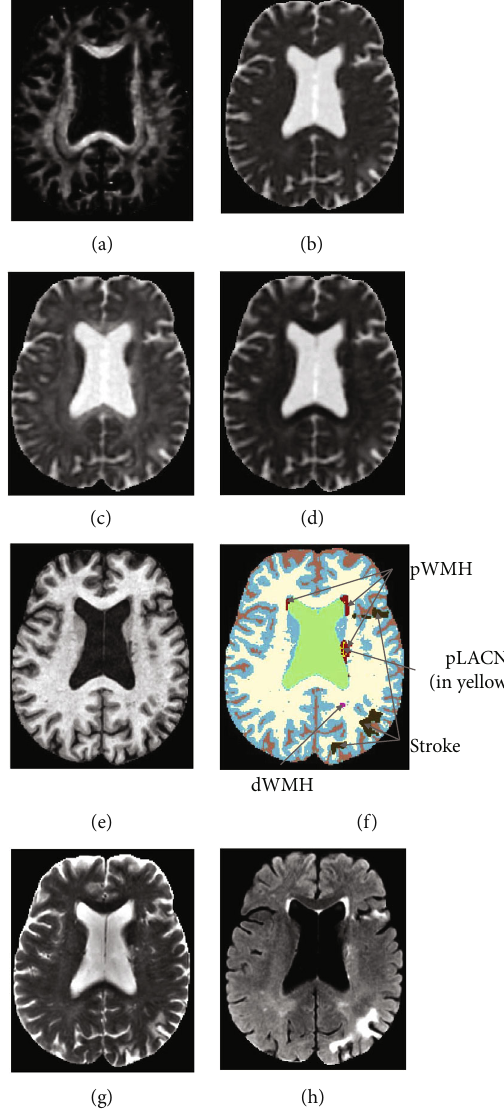
Figure 2: FA (a), MD (b), AD (c), and RD (d) maps produced by the DTI processing pipeline. Corresponding T (e), semiautomated segmentation of cerebral tissues/vascular lesions (f), T2-weighted image (g), and FLAIR image (h) are also provided. pLACN: periventricular lacuna; pWMH: periventricular white matter hyperintensities; dWMH: deep white matter